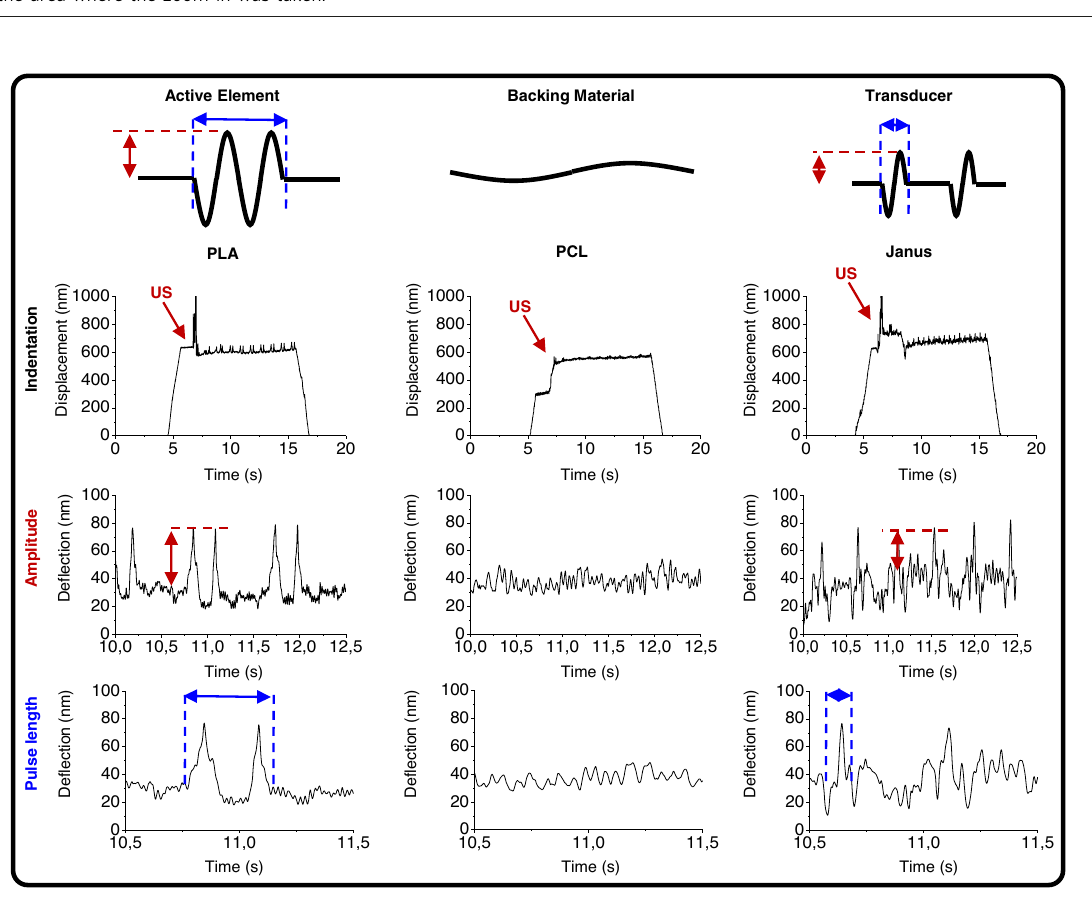
Fig. 2 FDM scaffolds respond to ultrasound stimulation affecting cell proliferation. a Schematic representation of the set-up used to stimulate hBMSC cultures showing fi xed FDM scaffolds and remote ultrasound stimulation. b Computational simulation of the de fl ection of the different scaffolds (Janus, PCL and PLA) under sound stimulation at 10, 20, or 40 kHz. Color scale represents de fl ection in nm. c Quanti fi cation of cell surface density in e (For stimulation at 0, 10, 20, and 40 kHz, n = 11, 4, 10, and 10 for PLA; n = 13, 4, 10, and 6 for PCL and n = 11, 5, 9, and 9 for Janus, respectively) Data is shown as means ± SEM and represents images from 3 biological triplicates. Statistical signi fi cance was calculated by two-way ANOVA with Tukey ’ s multiple comparison test; **** p < 0.0001, ** p < 0.01, and * p < 0.1. Source data and exact p values are provided as a Source Data fi le. d Cell proliferation as a function of the simulated scaffold de fl ection (nm) from measurements in c . Data is shown as means ± SEM. Black circles are individual data points. Dashed line represents cell number in hBMSC culture with 0 kHz stimulation. e Fluorescence microscopy images of hBMSCs cultured in Janus, PCL and PLA scaffolds and stimulated for 30 min at different frequencies for 7 days showing an ultrasound-dependent and material-dependent cell proliferation/density, n = 3. Labels indicate beam de fl ection as calculated in b and white dashed line de fi ne the limits of the fi ber. Cells were stained for F-actin (green) and DNA (blue). Scale bars represent 200 µ m, n = 3. f Fluorescent light microscopy images of hBMSCs cultured for 14 days on Janus, PCL and PLA scaffolds and stimulated for 30 min daily at 40 kHz. Cells were stained for F-actin (green), DNA (blue), and fi bronectin (red). Scale bars represent 200 µ m. White dash-line boxes represents the area where the zoom-in was taken.